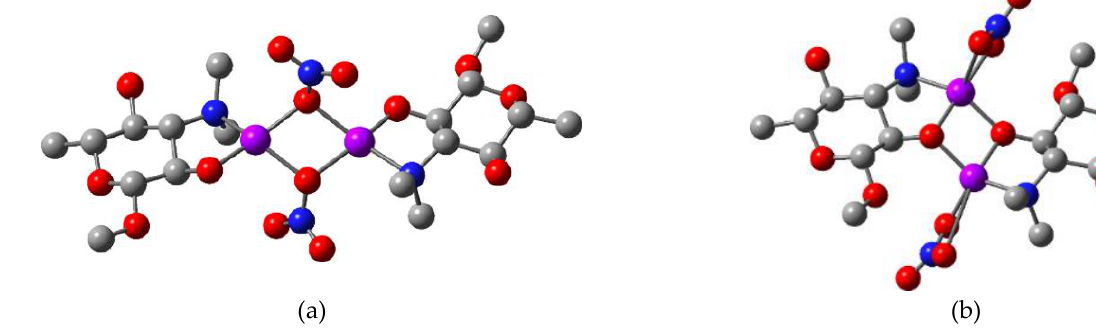
Figure 7. Structures of the possible complexation patterns for the dinuclear blue complexes —( a ) bridging nitrate ions ( 4 ) and ( b ) terminal nitrate ions ( 5 ). Hydrogen atoms are omitted for clarity. Colour code: C—grey, O—red, N—blue, Cu—magenta.